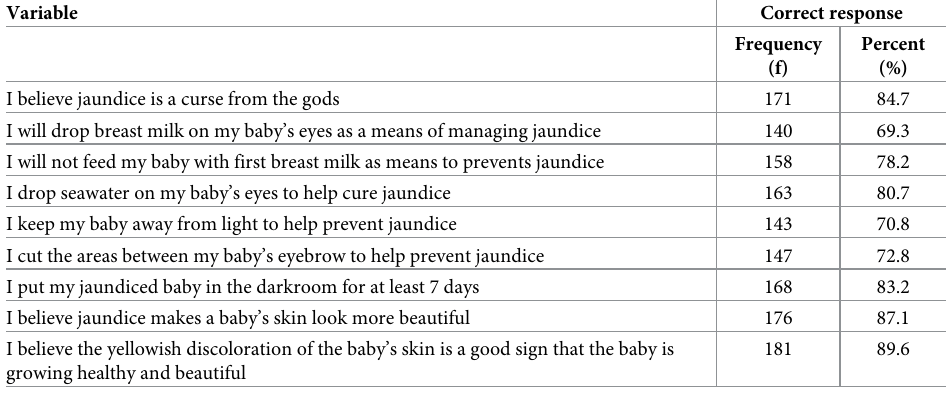
Table 4. Traditional beliefs and practice of caregivers towards neonatal